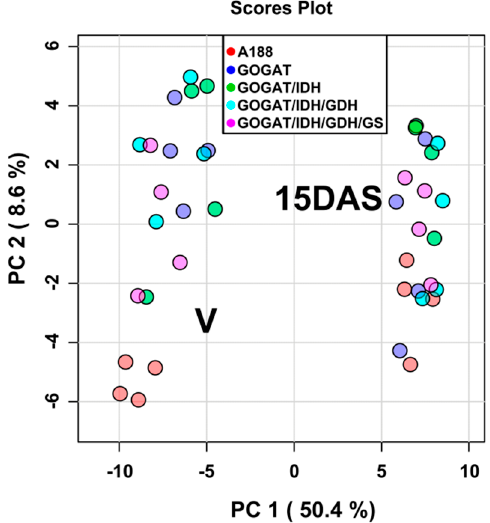
Figure 3. Principal component analysis (PCA) of the di ff erent leaf metabolites detected at the V stage and 15DAS of WT (A188) plants and transgenic maize lines overexpressing NADH-GOGAT (construct T02291) and NADH-GOGAT stacked with NAD-IDH (construct T02289), NAD-IDH + NADH-GDH1 (construct T02308) and NAD-IDH + NADH-GDH1 + GS1.3 (construct T02312). Metabolic and molecular traits were measured in the leaves of plants harvested at the vegetative (V) stage and 15 days after silking (15DAS). The four colored dots for each transgenic line correspond to the four independent transformation events selected for the metabolomic study. The values of the di ff erent metabolites were projected on to two biplots of principal components arranged in descending order of variance. Each component allowed the identification of groups of metabolites, depending on the plant developmental stage and of the nature of the